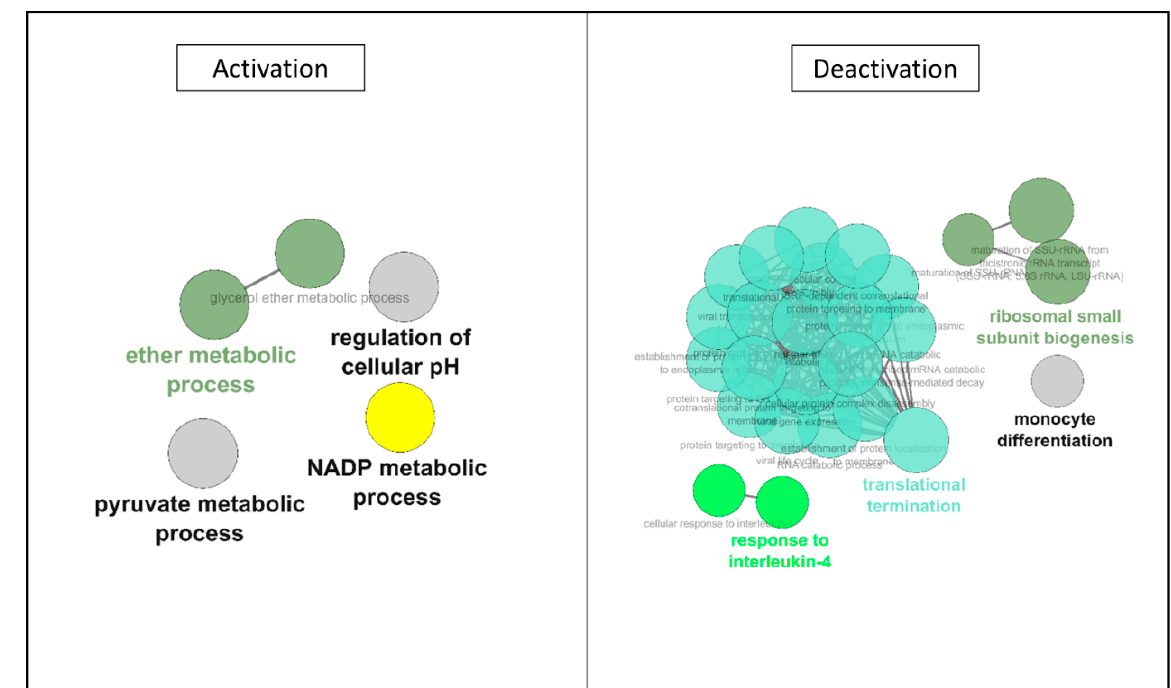
Figure 7. ClueGO Network Representation of Affected motifs after 6 h reoxygenation/rewarming. The list of protein motifs unaffected by the protocol were analyzed in Cytoscape’s ClueGO to identify their ontology and network associations. Results are illustrated as a functionally grouped network of terms/pathways. The most significant term of a group is considered to be the leading terms and is highlighted (bolded name). Disc size represents the number of motifs identified in the specified ontology (small: 3–6; medium: 7–9; large: 10 and